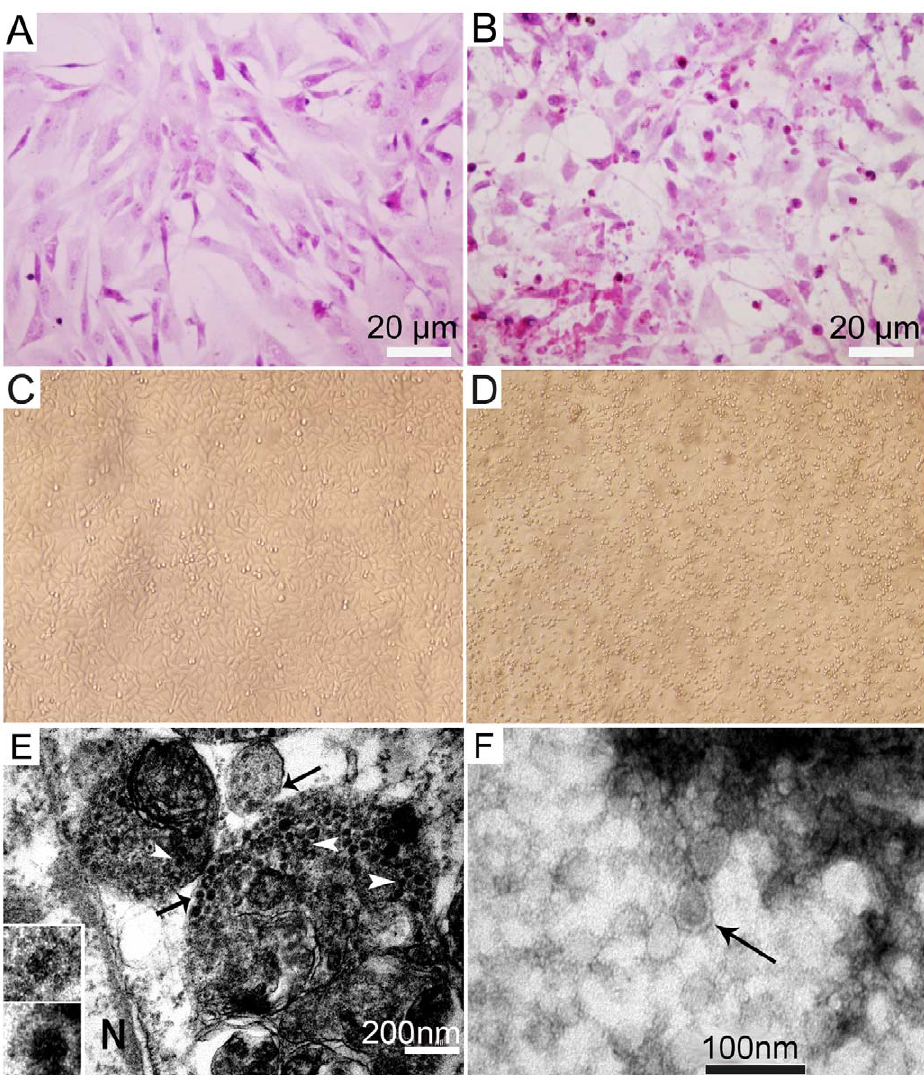
Figure 4. CPE in BYDV infected DEFs and electron micrographs of virus particles. HE-stained, non-infected DEF control (A); HE stained infected cells, 52 hrs post-infection, showing cell disruption with a large number of red-stained particles (B); Non-infected Vero cell monolayer (C); Infected Vero cells rounded up and focal detachment 60 hrs post-infection (D); Thin section of the infected cell, 24 hrs post-infection, showing dense particles (white arrow head) and virions (arrow) within the vesicles in the cytoplasm (N, nucleus). Insets are magnified virions (E); Negative staining of the purified BYDV from the cell culture supernatants (arrow indicates the typical enveloped flavivirus) (F).